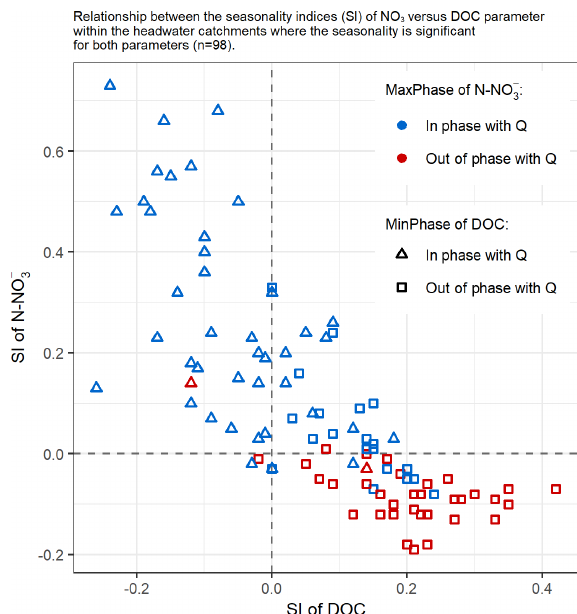
Figure 6. Relationship between the seasonality indices (SI) of ni- trate N (N-NO 3 ) vs. dissolved organic carbon (DOC) in the headwa- ter catchments for which seasonality was significant for both param- eters ( n = 98). The colour and shape of symbols identify the season- ality types based on the NO 3 MaxPhase and DOC MinPhase met- rics. The threshold date was 1 May: MaxPhase metrics that occurred before were classified as “in phase” with discharge ( Q ), while those that occurred after were “out of phase” with Q . The DOC MinPhase metric is shown to highlight the synchrony between minimum DOC and maximum N-NO 3